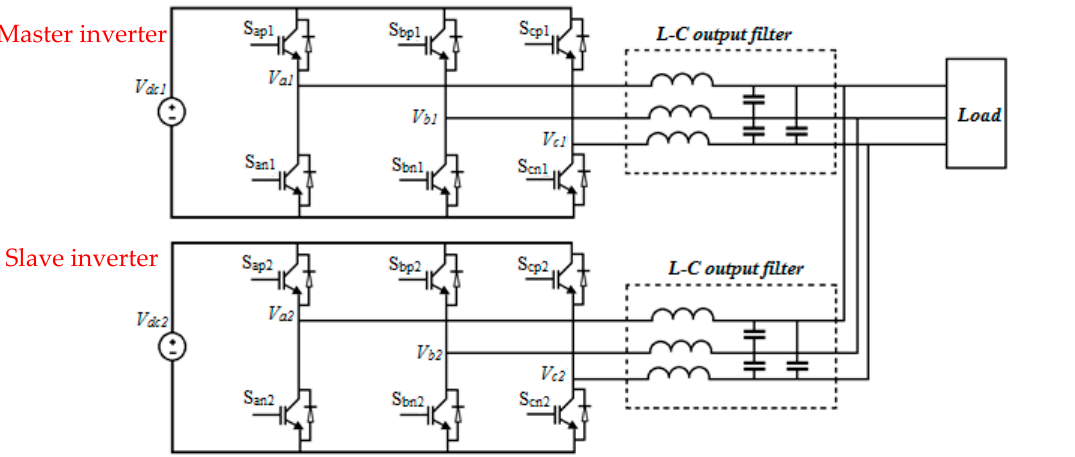
Figure 2. The dynamic model of the two parallel inverters. The parameters in matrices A and B are given in Table 1.